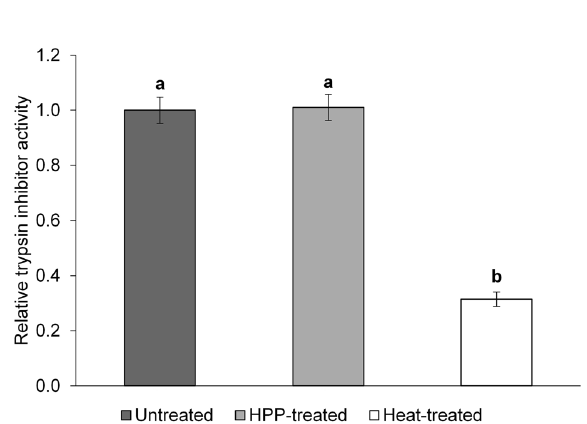
Fig. 5 Average relative trypsin inhibitor activity. The trypsin inhibitor activity assay was performed independently in triplicate, where the trypsin inhibitor activity (mg trypsin inhibited/g protein) for each independent replicate was an average of three technical replicates. Bars represent the average relative trypsin inhibitor activity (unitless) with respect to the average untreated trypsin inhibitor activity (average trypsin inhibitor activity/average trypsin inhibitor activity of untreated). Error bars display the standard deviation. Letters above the bars indicate statistically signi fi cant differences ( p < 0.05).